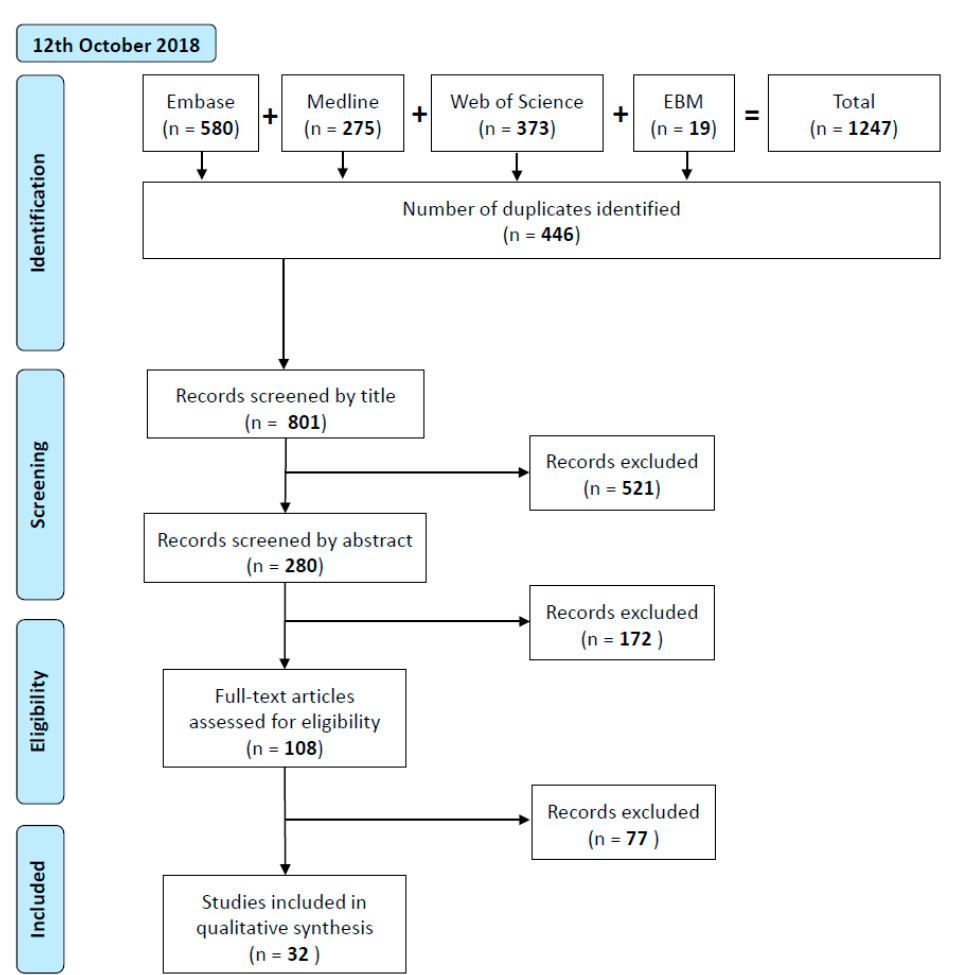
Figure 2. Flow diagram of selection of studies eligible for inclusion.